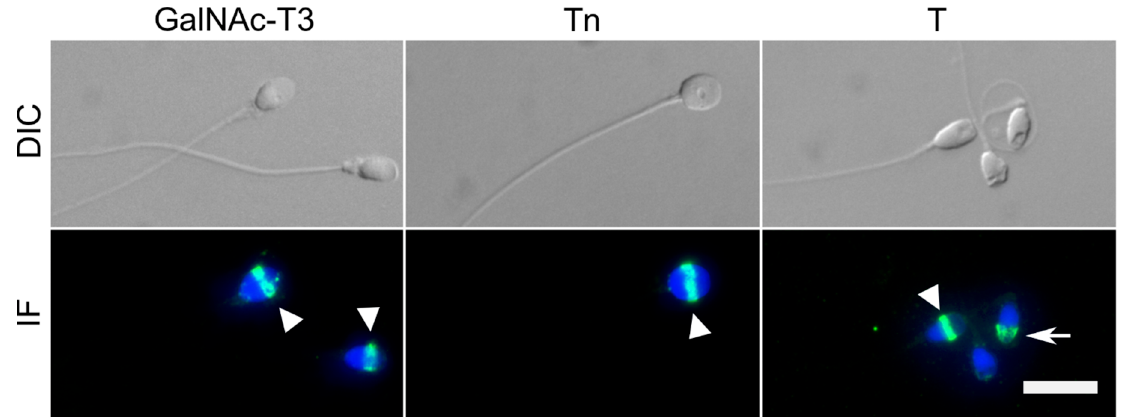
Figure 1. Localization of GalNAc-T3 in human spermatozoa. Top panel: Digital Interference Contrast (DIC) images of human spermatozoa. Lower panel: Immunofluorescence (IF) images of GalNAc-T3 (mAb UH5, 2D10) and simple mucin-type O -glycosylation Tn (mAb 5F4) and T (mAb 3C9). Nuclei of the spermatozoa were stained with 4’,6-diamidino-2-phenylindole (DAPI). GalNAc-T3, Tn, and T antigen all localised to the equatorial segment of sperm cells as indicated by the arrowhead. The T antigen was also present in the acrosomal cap (arrow). Scalebar 10 µm.